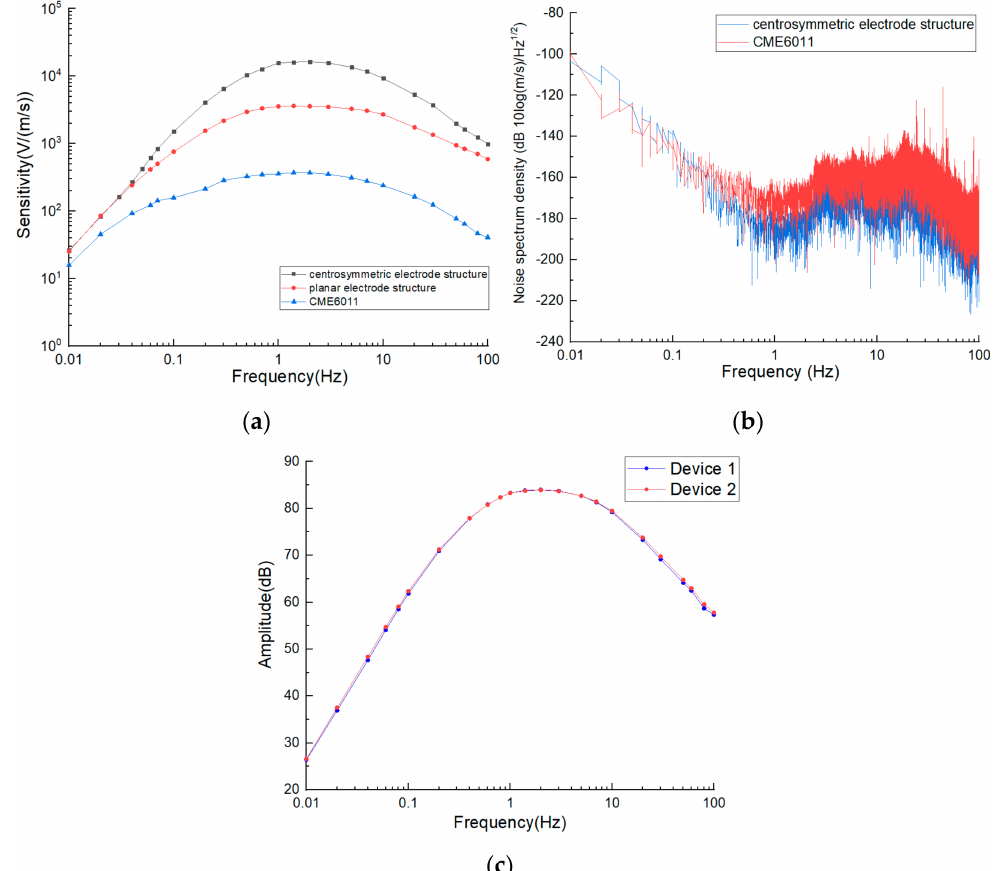
Figure 6. Characterization results: ( a ) amplitude frequency response and ( b ) noise spectrum densities of the electrochemical seismic sensor based on the integrated structure of four centrosymmetric micro electrodes, in comparison to the commercial counterpart of CME6011 and the electrochemical seismic sensor based on the integrative structure of four planar micro electrodes. ( c ) amplitude frequency response of two electrochemical seismic sensors based on the integrated structure of four centrosymmetric micro